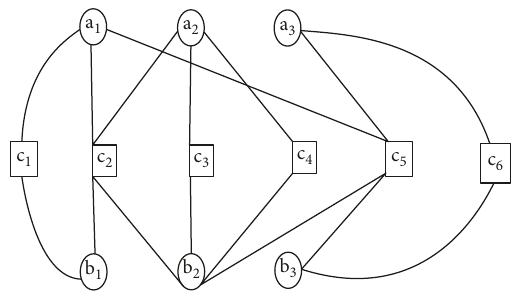
Figure 1: Hyper graph (manpower, machines, production